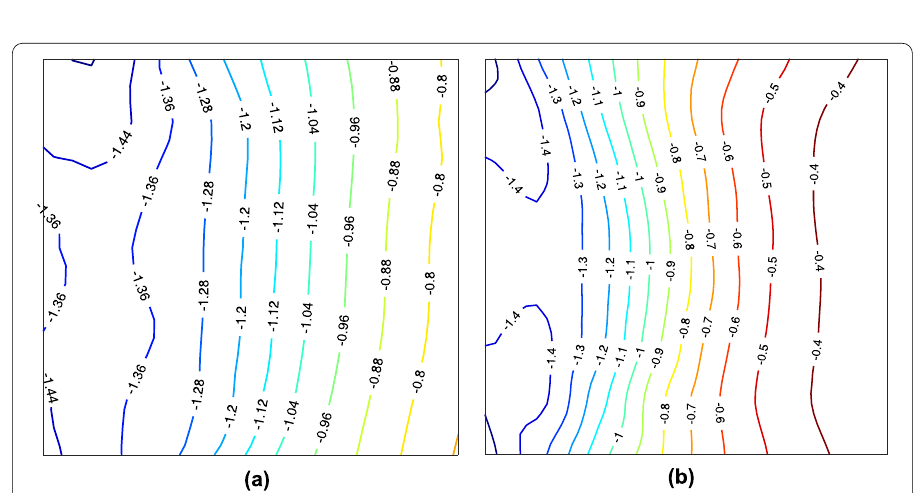
Fig. 10 Mean pressure coefficients (0 deg.): ( a ) LSU open-jet, and ( b ) TPU wind tunnel (wind from left to